Question: What style of plot is this figure drawn as?
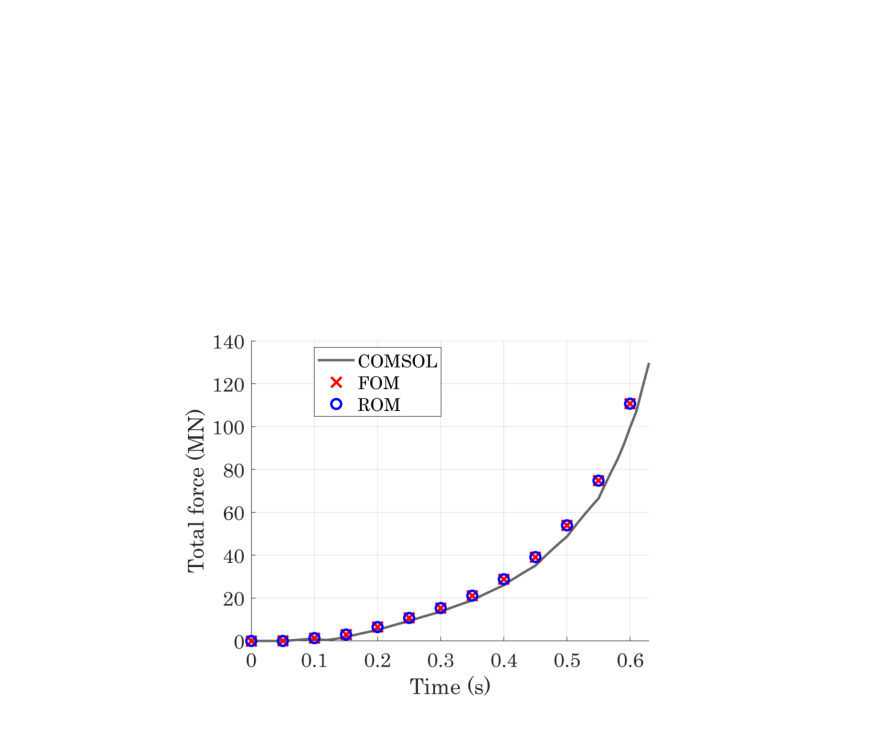
Answer: line